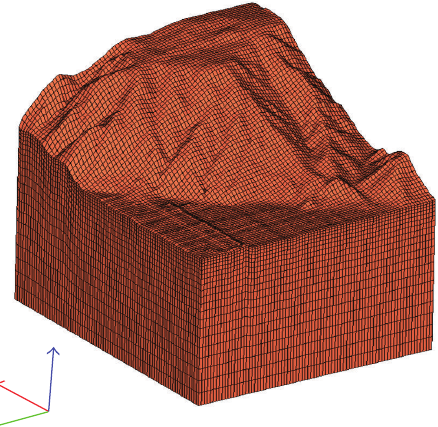
Figure 7: Three-dimensional finite element model of the whole slope.